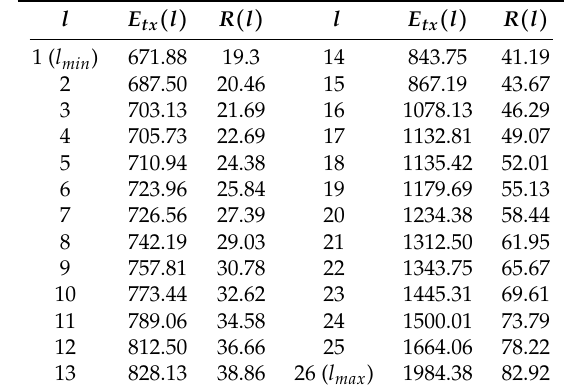
Table 1. Transmission energy consumption ( E tx ( l ) in nJ / bit ) and transmission range ( R ( l ) in m ) at each power level ( l ) for the Mica2 motes as a function of power level [14]. Energy dissipation for reception of data is constant ( E rx = 922 nJ / bit